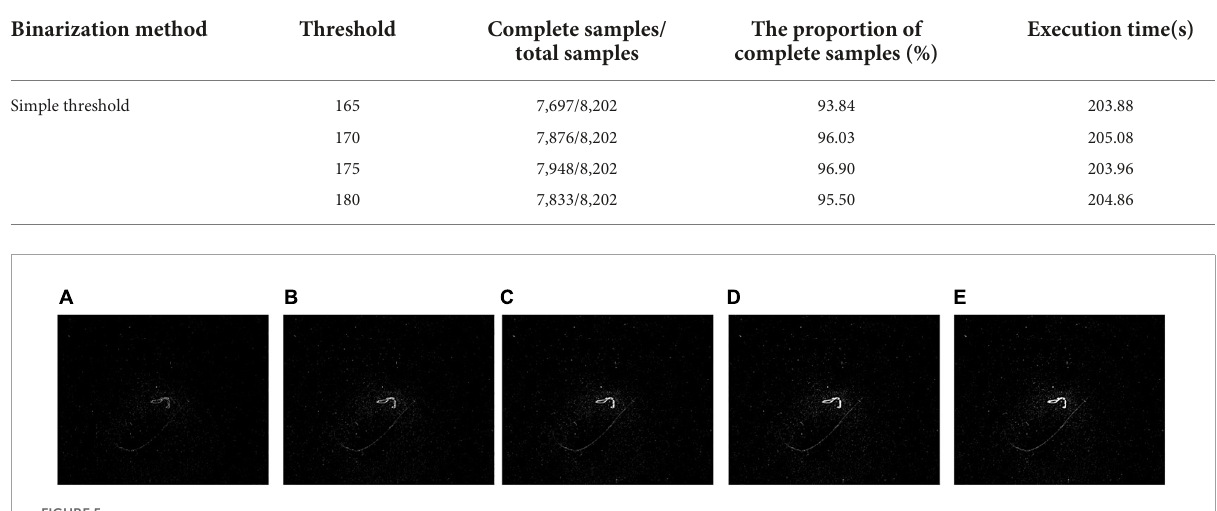
FIGURE5 Results of adaptive threshold binarization under different neighborhood block sizes. (A) 7 × 7, (B) 13 × 13, (C) 19 × 19, (D) 25 × 25, and (E) 31 × 31.